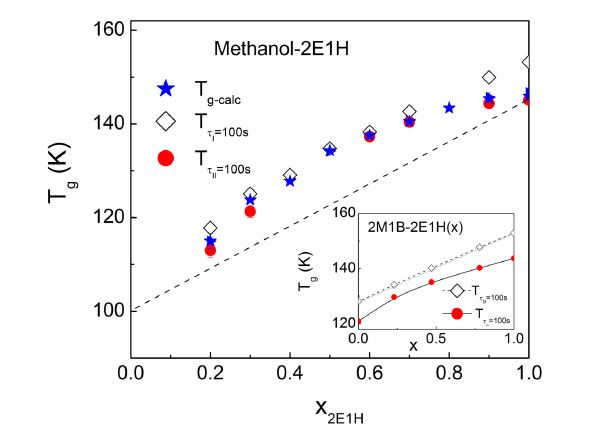
FigUre 7 | comparison of the glass transition temperatures defined in calorimetric and kinetic measurements for the methanol – 2e1h mixtures . Calorimetric T g–cal is defined as the onset temperature in the heat capacity jump from the glassy to liquid states as shown in Figure 4 , while kinetic T τ of the relaxation I and T τ of the relaxation II are α = 100 s D = 100 s determined by a temperature at which the dielectric relaxation time is 100 s. T T τ D = 100 s and τ α = 100 s in the mixtures composed of 2E1H and 2-methyl-1- butanol (2M1B) from Wang and Richert (2005b) are plotted in the inset. x is the mole fraction of 2E1H.